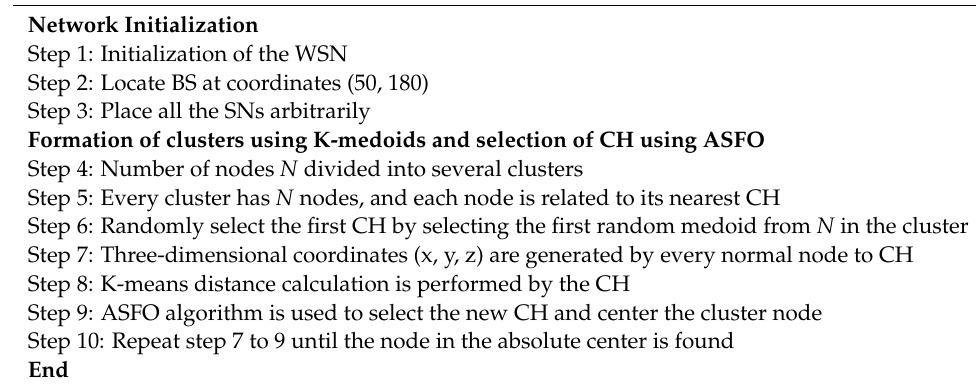
Algorithm 1: Algorithm for clustering using K-medoids with a Sailfish Optimizer Network